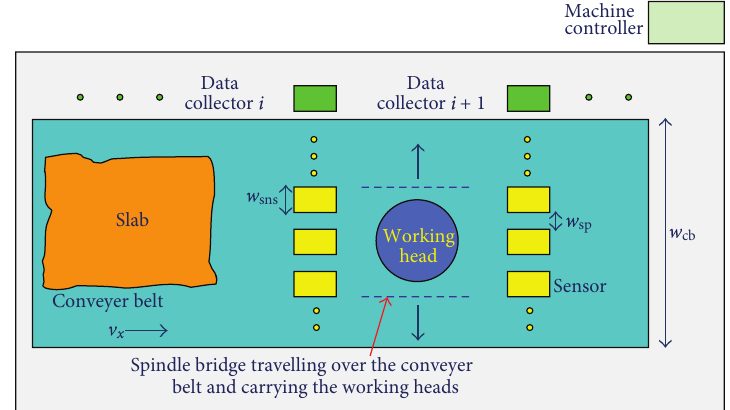
F 31: Schematic representation of the machine sensing and data collection